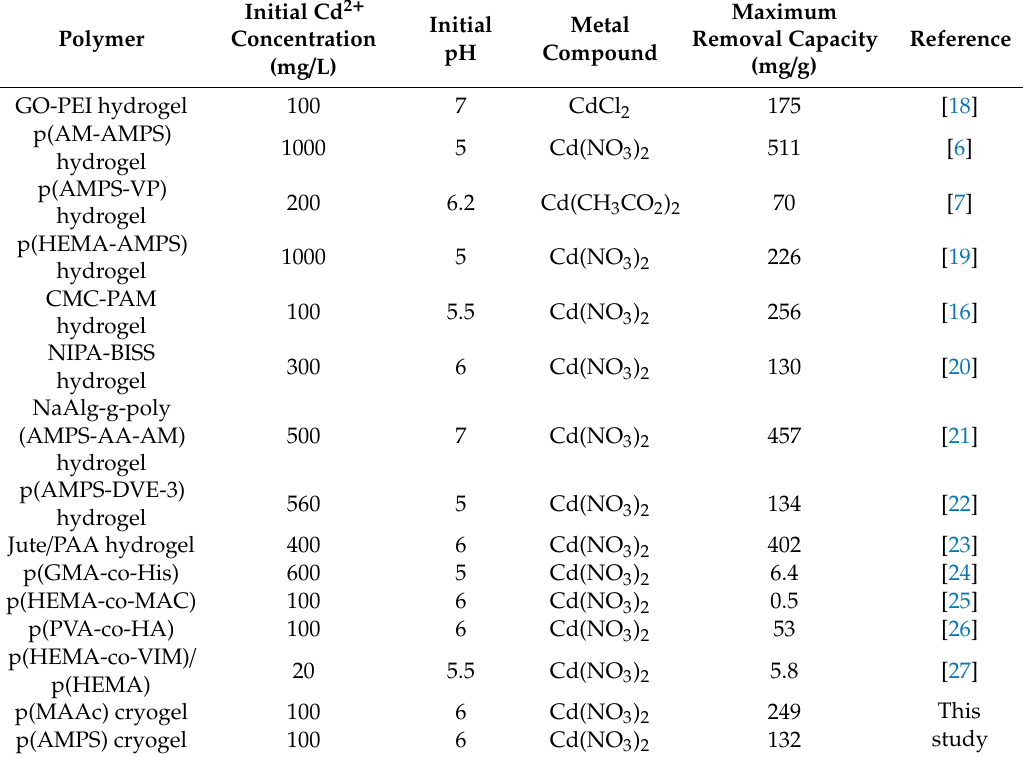
Table 1. Polymeric materials for the removal of Cd 2 + from the aqueous solutions.